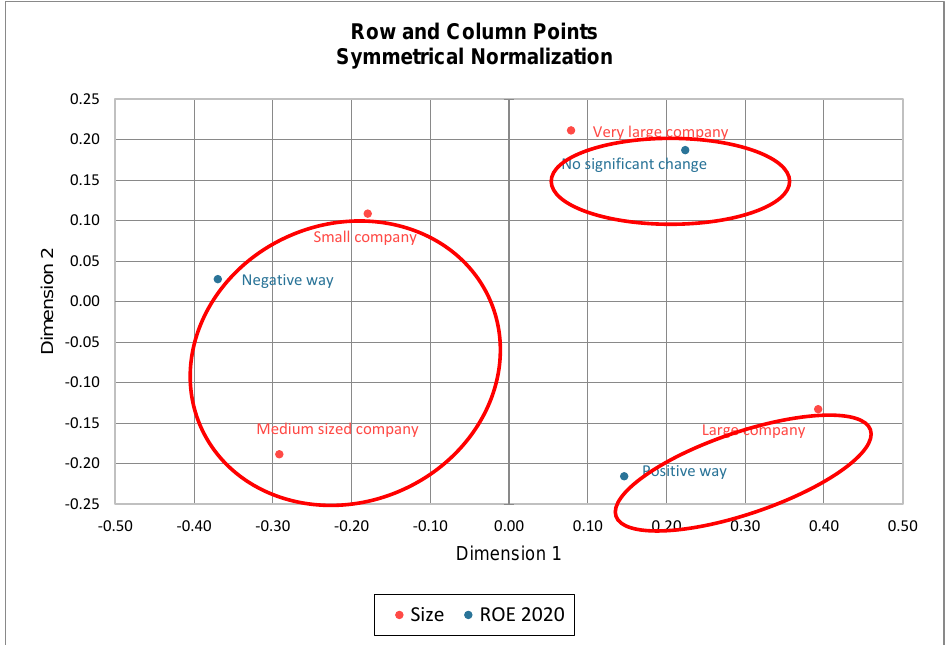
Figure 10. Correspondence map for ROE indicators in 2020 and enterprise size categories. Source: own research .